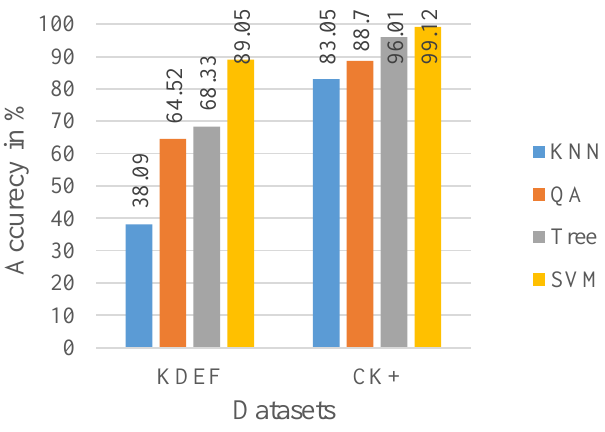
Figure 12. KDEF (KNN: 38.09, QA: 64.52, Tree: 68.33, SVM: 89.05), CK+ (KNN: 83.05, QA: 88.70, Tree: 96.01, SVM: 99.12). Table 3. Confusion matrix of the CK+ dataset (SVM).